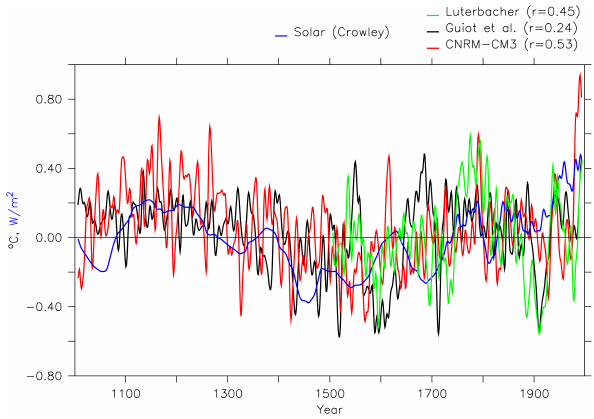
Fig. 1. Time series of the summer (April to September) European Figure 1. Time series of the summer (April to September) European mean temperature (in °C) 2 mean temperature (in ◦ C) filtered with a 13yr cutoff value. In black filtered with a 13 yr cutoff value. In black is the reconstruction from Guiot et al. (2010), in 3 is the reconstruction from Guiot et al. (2010), in green is the re- green is the reconstruction from Luterbacher et al. (2004) and in red is the simulation from the 4 construction from Luterbacher et al. (2004) and in red is the sim- model CNRM-CM3. In blue is represented the mean radiative forcing from solar variations 5 ulation from the model CNRM-CM3. In blue the mean radiative (in W.m -2 ) from Crowley (2000) with its own axis in blue on the left. The spatial average is 6 forcing from solar variations (in Wm − 2 ) is represented from Crow- computed over the region 10°W-60°E, 25°N-75°N in the Guiot et al. (2010) reconstruction 7 ley (2000) with its own axis in blue on the left. The spatial average is and in the model and over a smaller region (10°W-40°E, 35°N-70°N) for the Luterbacher et 8 computed over the region 10 ◦ W–60 ◦ E, 25 ◦ N–75 ◦ N in the Guiot al. (2004) reconstruction. 9 et al. (2010) reconstruction and in the model and over a smaller re- gion (10 ◦ W–40 ◦ E, 35 ◦ N–70 ◦ N) for the Luterbacher et al. (2004)